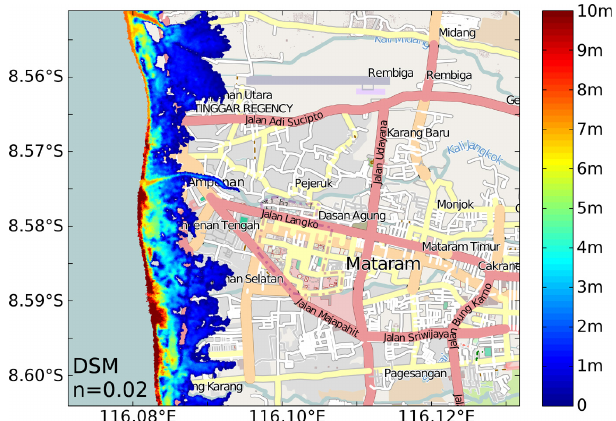
Fig. 17. Flowdepth in the model study for Mataram/Lombok (back- ground © OpenStreetMap contributors) based on Intermap DSM with constant Manning value n =0.02.